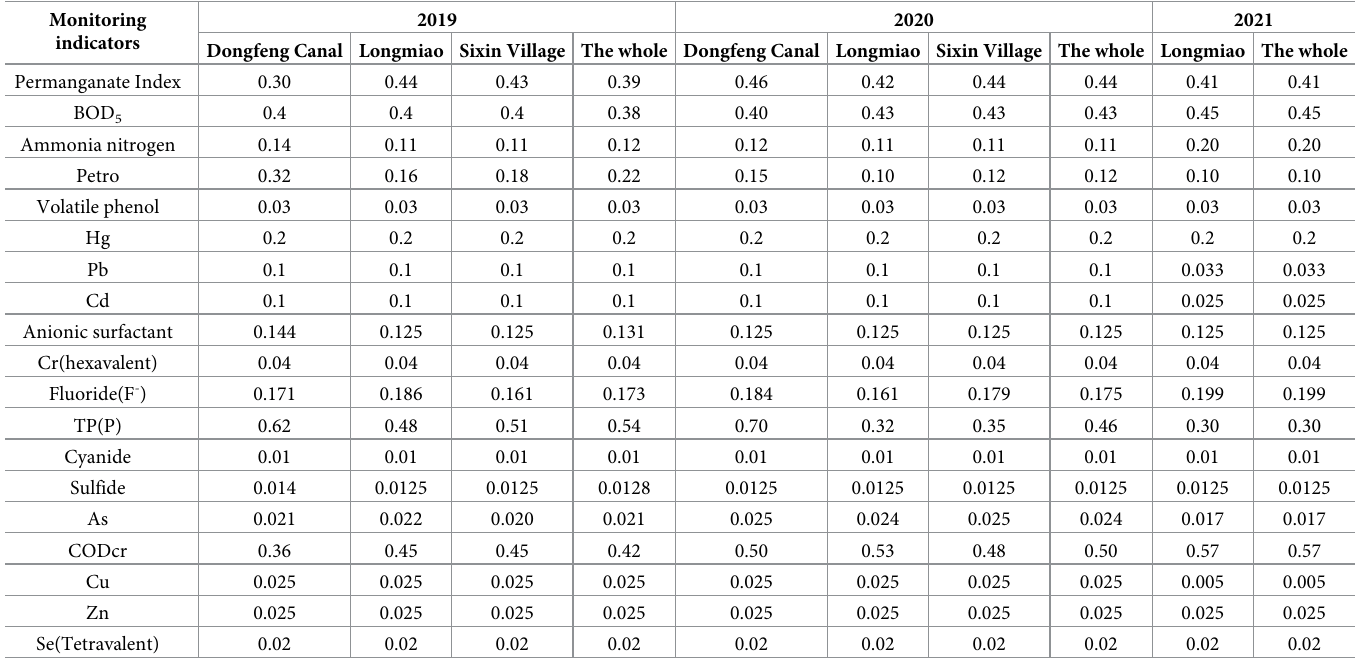
Table 6. Single factor index values for monitoring indicators